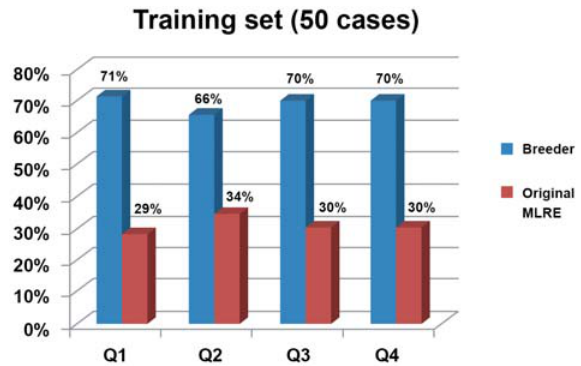
Figure 1- Predictions on the training